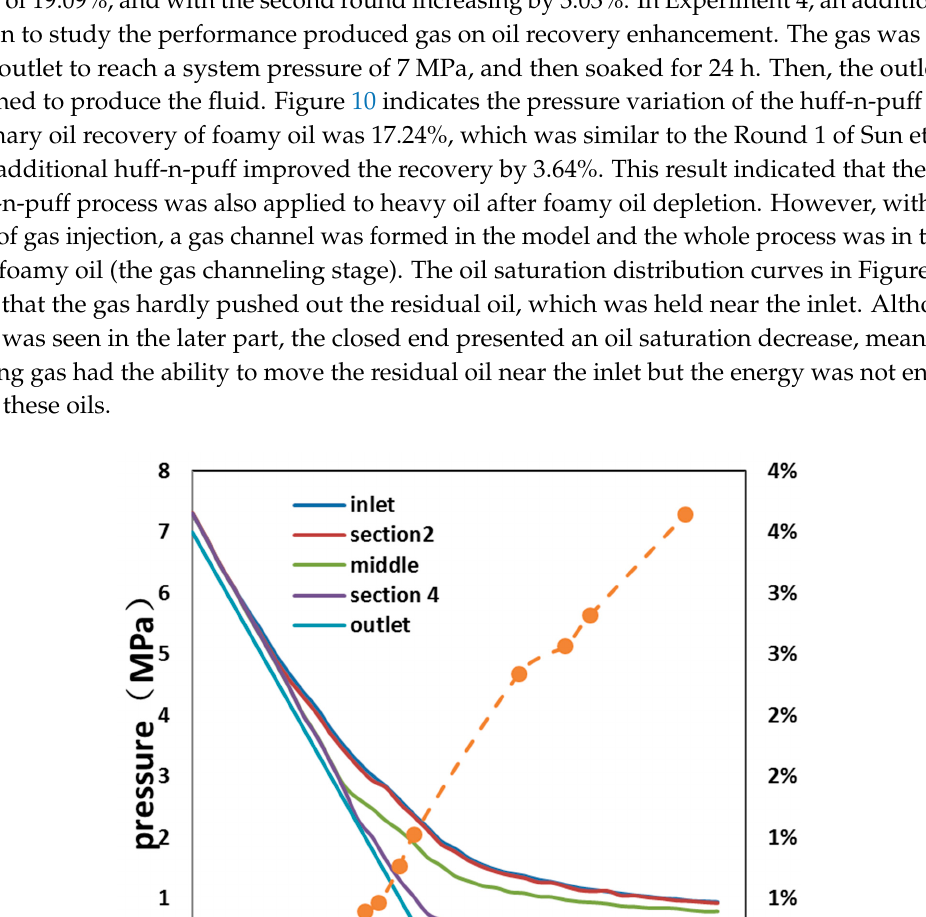
Figure 11. Oil saturation distribution curves in Experiment 4—gas cycling part. 3.5. Effect of the Sandpack Permeability on the Linear Depletion Process With a sandpack with higher permeability in Experiment 5, Figure 12 shows more swept area and better oil recovery. However, the behavior of the fluid production was similar to the other linear process—that is, the oil saturation increased near the outlet and the recovery improved to 25.10%. This phenomenon occurred because, with higher permeability, the oil could more easily migrate to